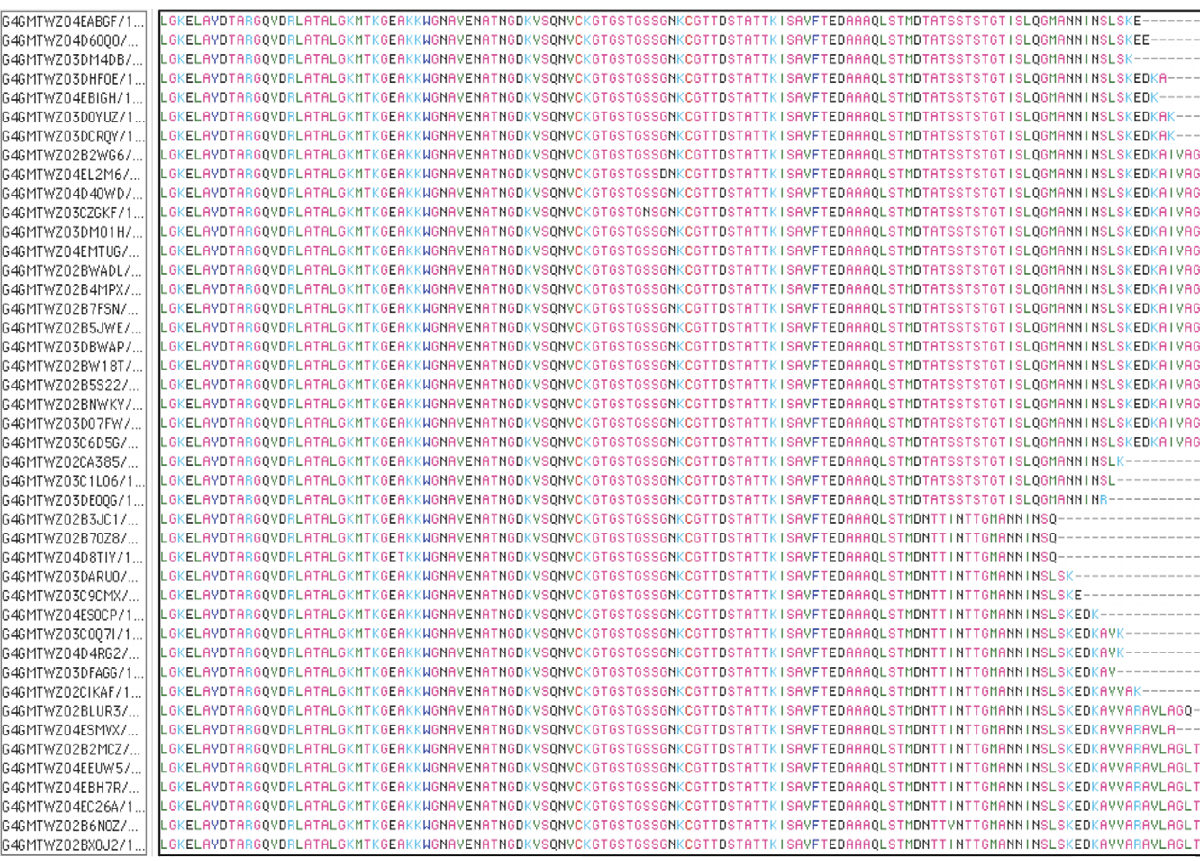
Figure 3. Extraction of different msp2 pseudogenes from amplified genomic DNA using Se-Al. Following alignment of reads with Mafft and separation into similar sequence groups, the read groups were edited manually with Se-Al. There are clearly two major groups of sequence reads represented in this alignment, which are derived from pseudogenes AMF_872 and AMF_1018 of the FL strain.